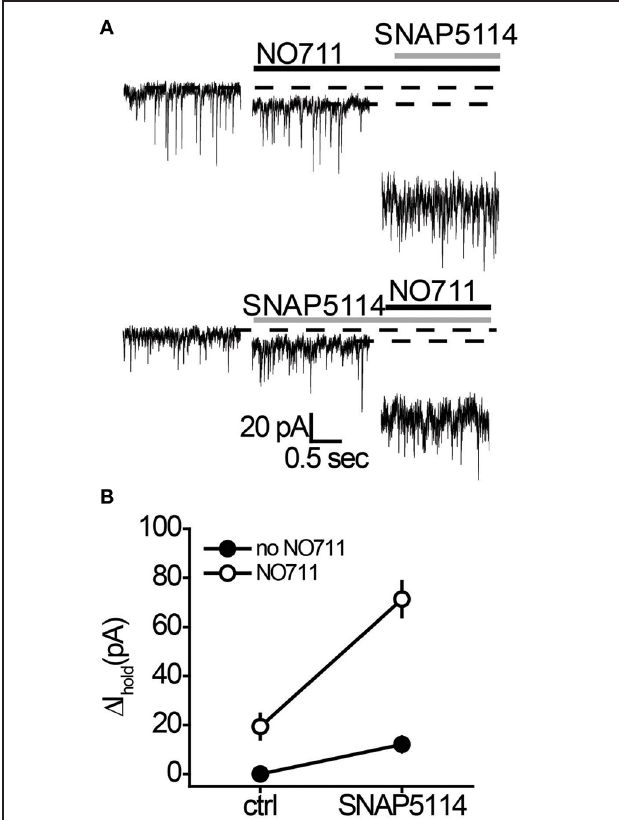
FIGURE 2 | A proportion of the tonic GABA A current in hippocampal interneurons is independent of vesicular GABA release. (A) Representative traces showing picrotoxin (PTX)-sensitive tonic current in a control slice and a slice treated with bafilomycin A1 ( Baf. A1); black line— PTX application. (B) Mean I spont in control ( n = 14) and bafilomycin A1-treated slices ( n = 6). (C) Mean tonic GABA A current ( (cid:2) I hold , n = 14) in control and bafilomycin A1-treated slices ( n = 6). ∗ P < 0 . 05, ∗∗ P < 0 . 01, unpaired t